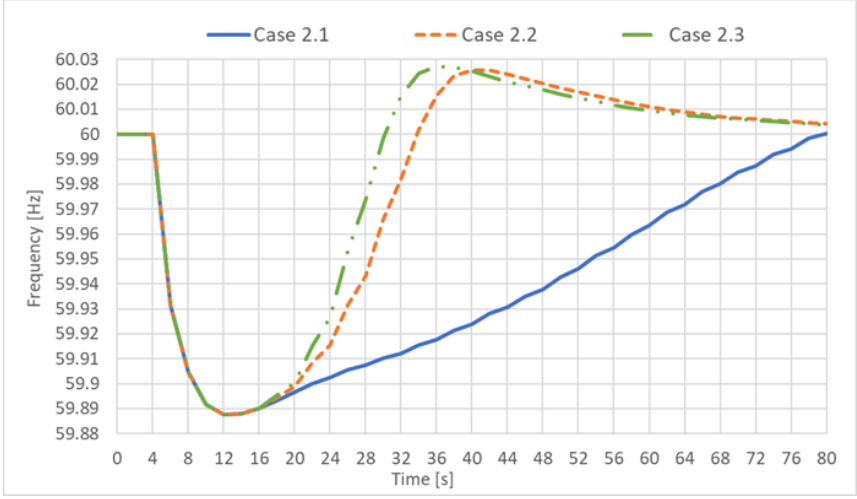
Figure 20. Comparison of frequency responses with different control gains.